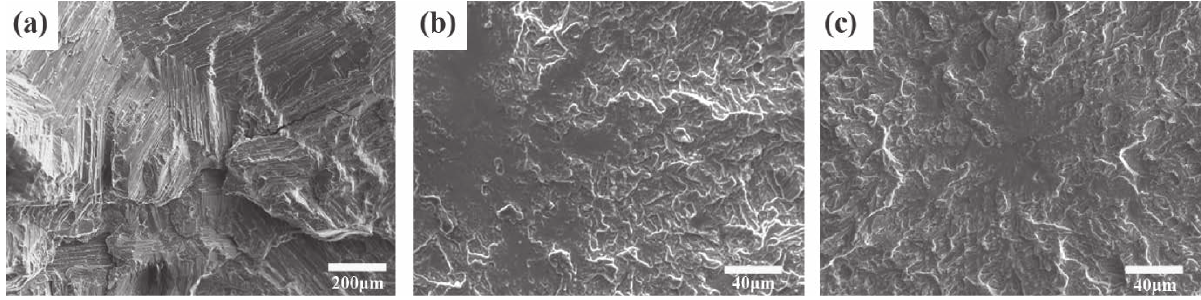
Fig. 7: SEM micrographs of the fracture surfaces: (a) as-cast; (b) DS; (c) DS +